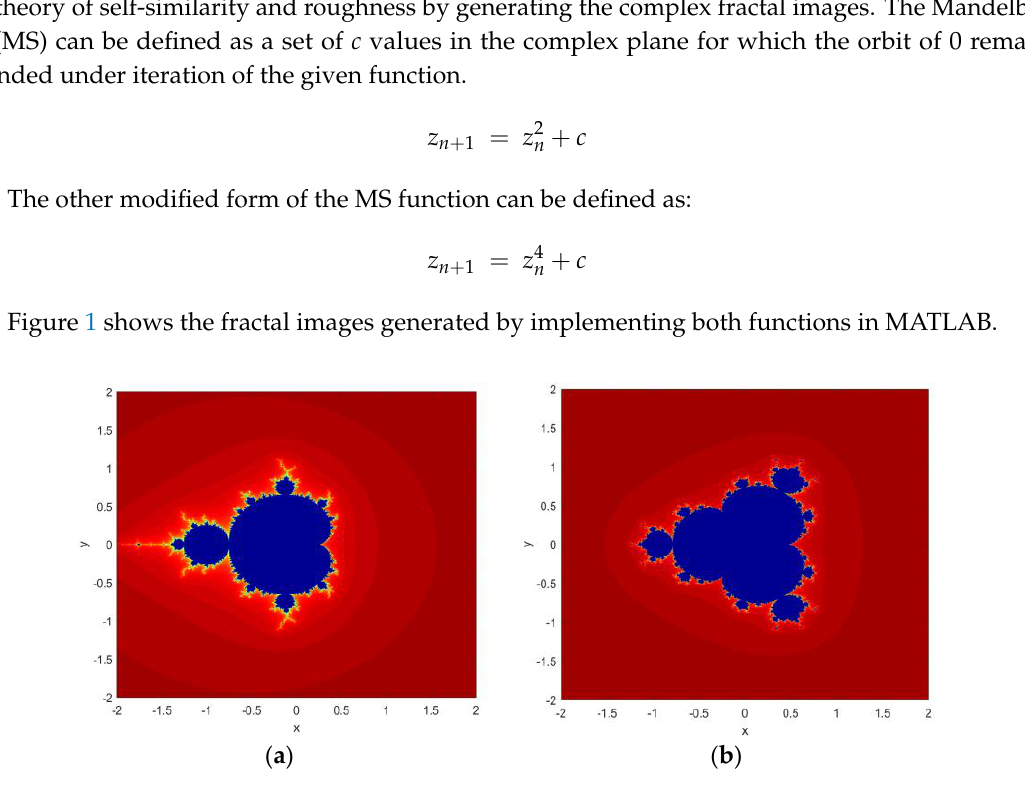
Figure 1. Fractal images generated from MS: ( a ) Equation (1); ( b ) Equation (2).